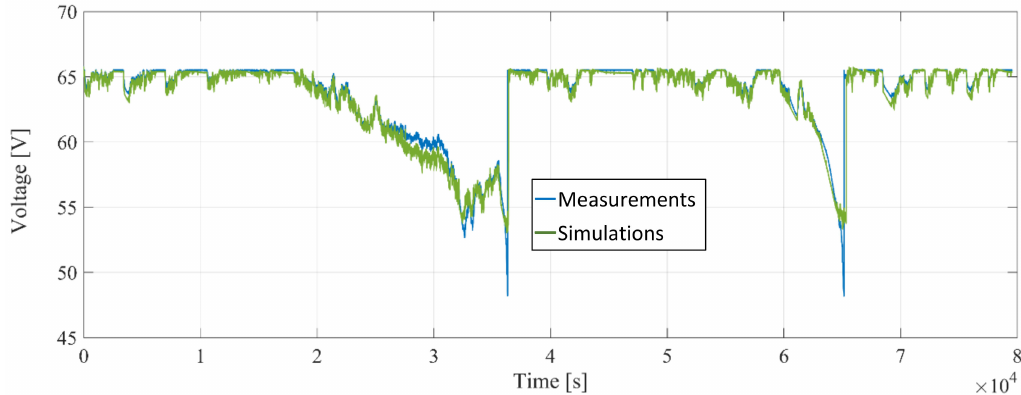
Figure 9. Comparison between model results and experimental measurements once the aging effect has been taken into account in the